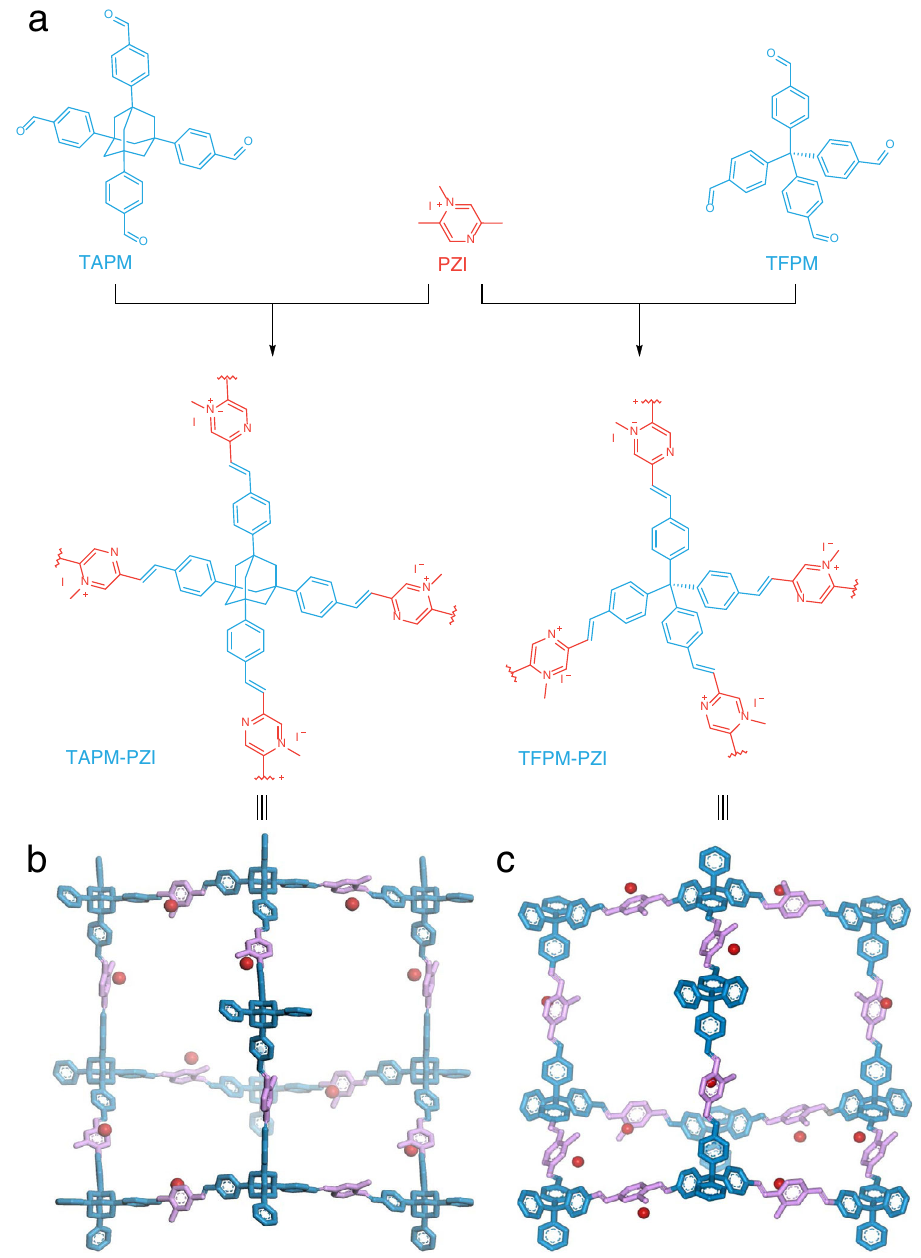
Fig. 1 | Schematic of synthetic ionic 3D sp 2 carbon-linked COFs. a Schematic synthesis of the ionic vinylidene-linked 3D COFs. The adamantane-knotted cage in the diamond net of b TAPM-PZI and c TFPM-PZI,